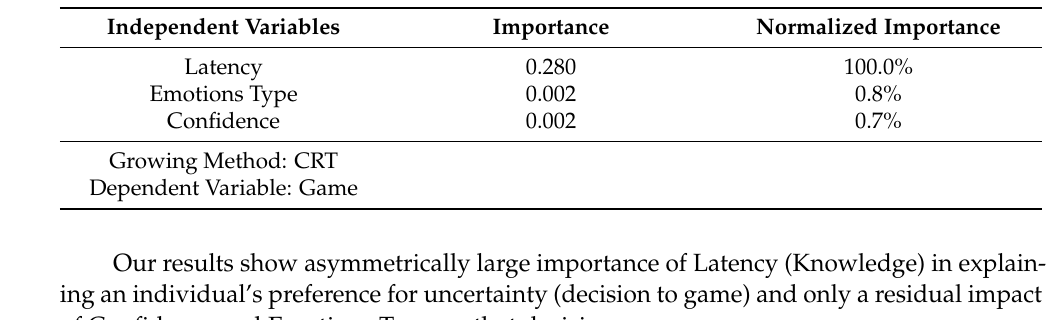
Table 6. CART—Independent Variables.